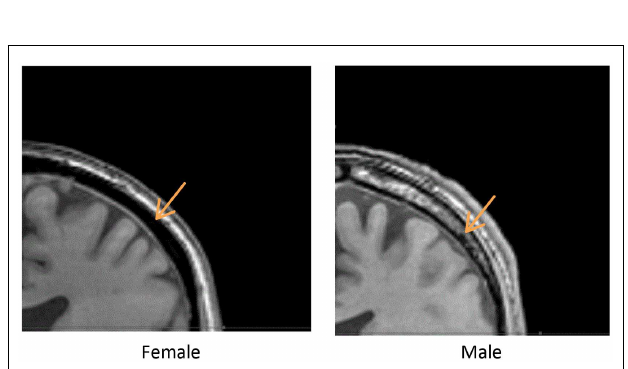
FIGURE 6 |Above are two parietal coronal MRI sections through male (right) and female (left) heads .The arrows point to the cancelous bone